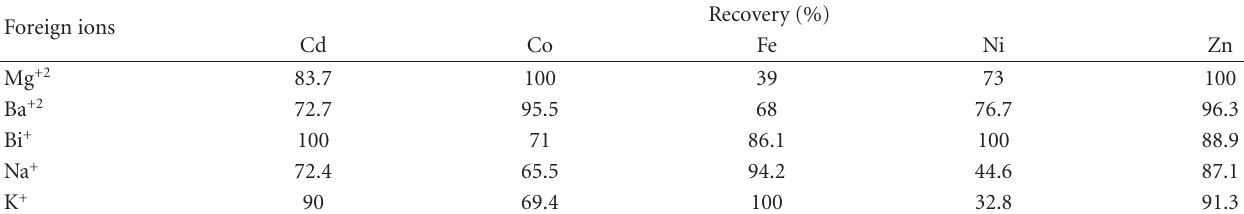
Table 3: E ff ects of the interferences ions on the recoveries of the examined metal ions.